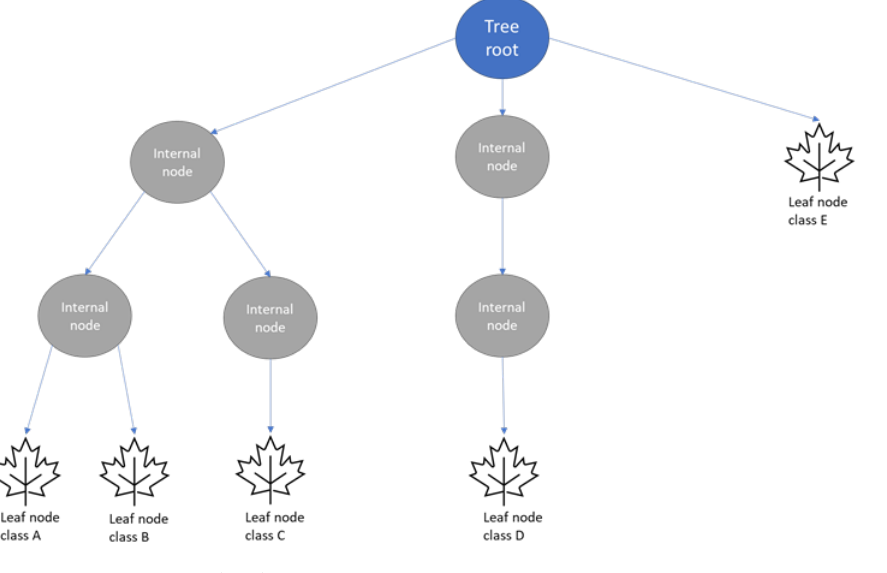
Figure 5. Decision trees (DTs).